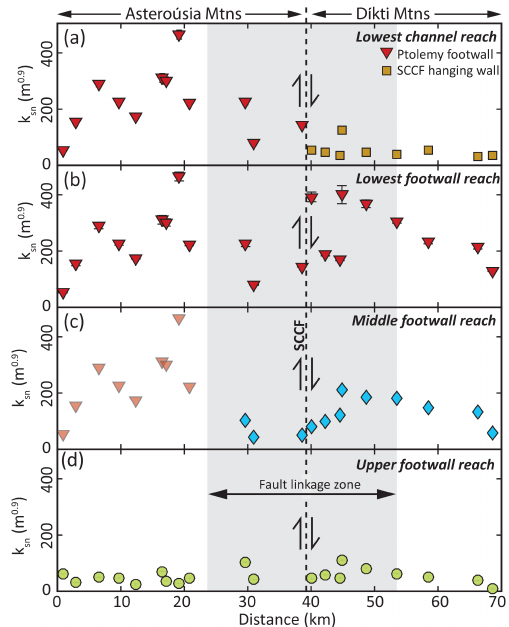
Figure 6. Normalized steepness index ( k sn ) for channel segments bound by knickpoints. The location where the South-Central Crete fault (SCCF) separates river channels in the footwall and hanging wall is shown as the vertical dashed line. (a) Data for the lowest river reaches. Note that for basins 1–12 the lowest reach is in the fault footwall, whereas for basins 13–21 the lowest reach is in the fault hanging wall. (b) The normalized steepness index for the low- est river reaches in the both footwalls. (c) Data for the middle reach for rivers that contain two knickpoints (basins 10–12) and lowest reach for rivers with only one knickpoint (basins 1–9). (d) The normalized steepness index for the river reaches above the highest